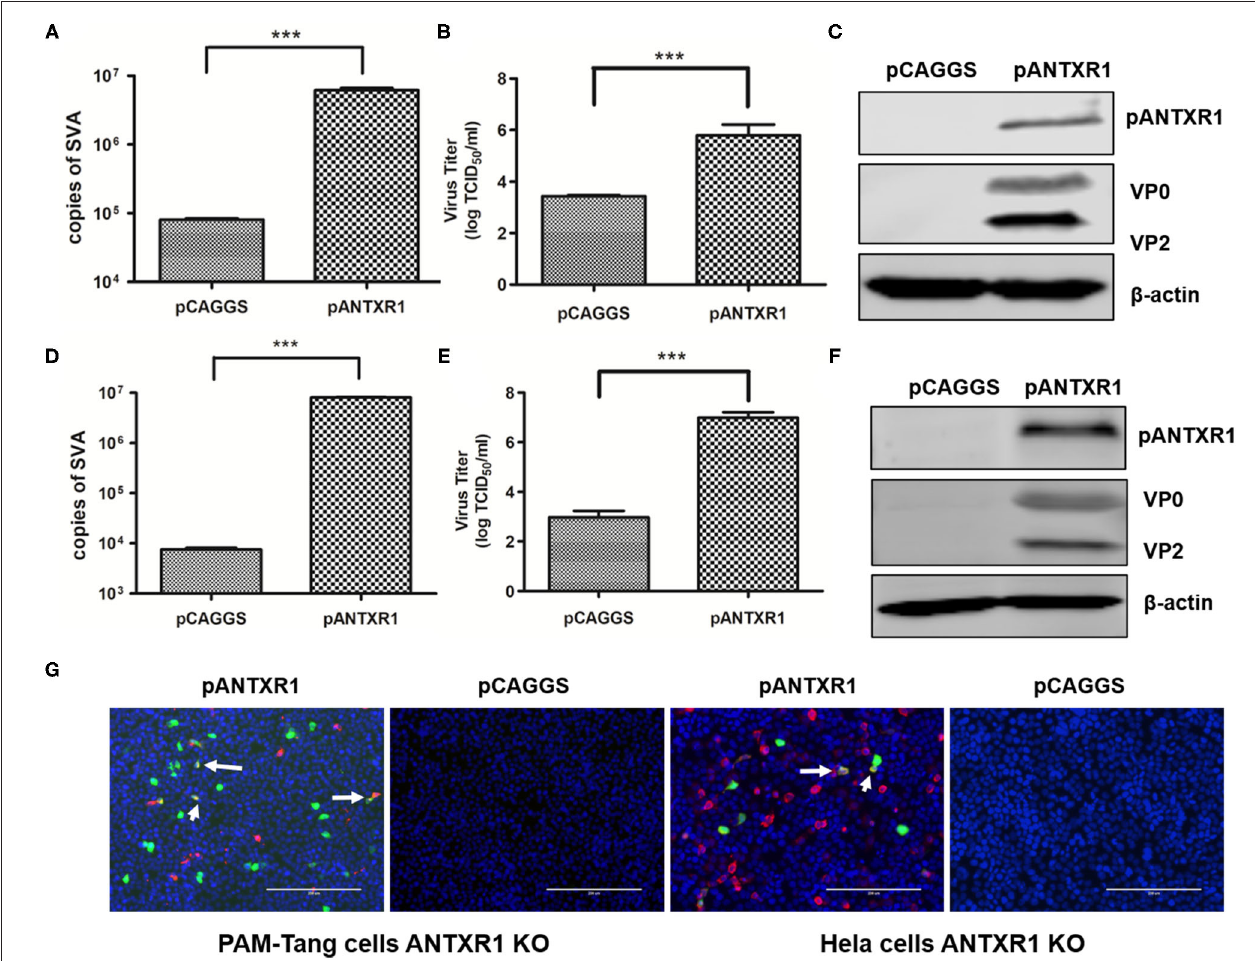
FIGURE 4 | Exogenous re-expression of the pANTXR1 promoted SVA infectivity. pCAGGS-pANTXR1 plasmid was transfected into Hela KO cells and PAM-Tang KO cells, and the pANTXR1 re-expressing cells were inoculated with SVA at an MOI of 0.1 (A) The qPCR analysis of SVA copy numbers in the Hela KO cells (*** p < 0.001). (B) The TCID 50 assay for SVA titers in Hela KO cells (*** p < 0.001). (C) The western blot assay for the expression of SVA VP2 and VP0 proteins and pANTXR1 from Hela KO cells. (D) The qPCR analysis of SVA copy numbers in the PAM-Tang KO cells (*** p < 0.001). (E) The TCID 50 assay for SVA titers in PAM-Tang KO cells (*** p < 0.001). (F) The western blot assay for the expression of SVA VP2 and VP0 proteins and pANTXR1 from PAM-Tang KO cells. (G) Immunofluorescent assay for pANTXR1 (in red) and EGFP (in green) expression level in the pANTXR1 re-expressed PAM-Tang KO cells and Hela KO cells. The colocalization of pANTXR1 with EGFP was indicated by arrow. Bars, 200 µ